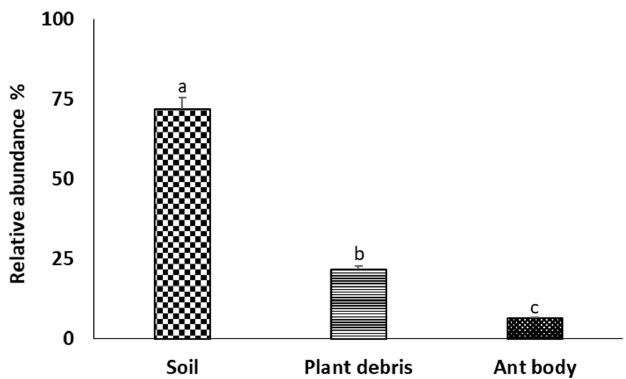
Figure 4. The distribution of fungal taxa across substrates: ant body, plant debris, and mound soils. Bars (±SE) with different letters designate significant differences at p < 0.05 (LSD after one ‐ way ANOVA.